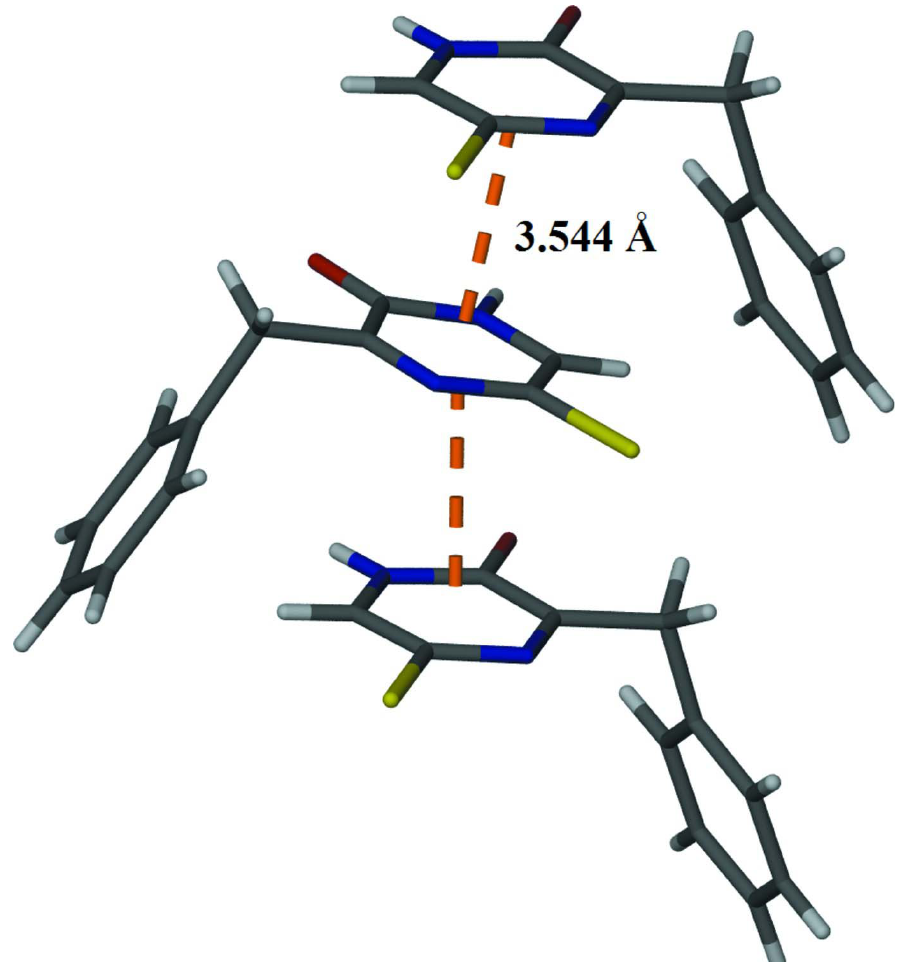
Capped-stick representation showing the π - π stacking geometry of (I) (dashed orange